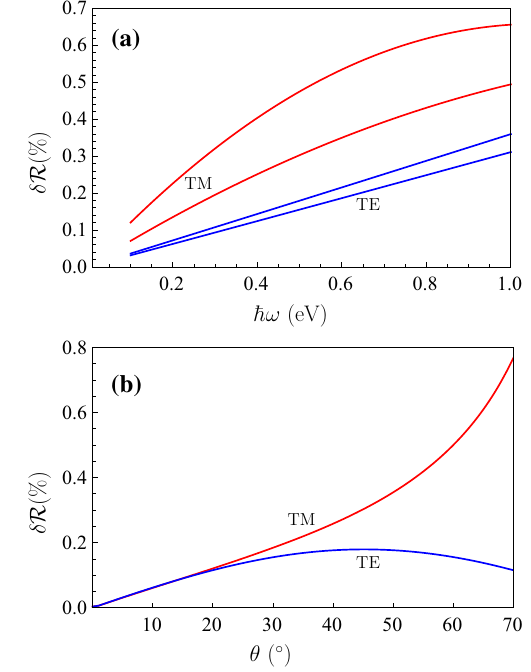
Fig. 4 Relativedeviationsbetweenthereflectancesofelectromagnetic waves on the mass shell incident on an Au plate under the angle θ , which are computed using the alternative nonlocal and standard Drude responses, are shown as a the functions of frequency by the top and bottom pairs of lines for the TM and TE polarizations, respectively (the upper and lower lines in the top pair are for θ = π/ 3 and π/ 4, respectively, and vice versa for the bottom pair) and b the functions of the incidence angle at ¯ h ω = 0 . 5 eV by the top and bottom lines for the TM and TE polarizations,